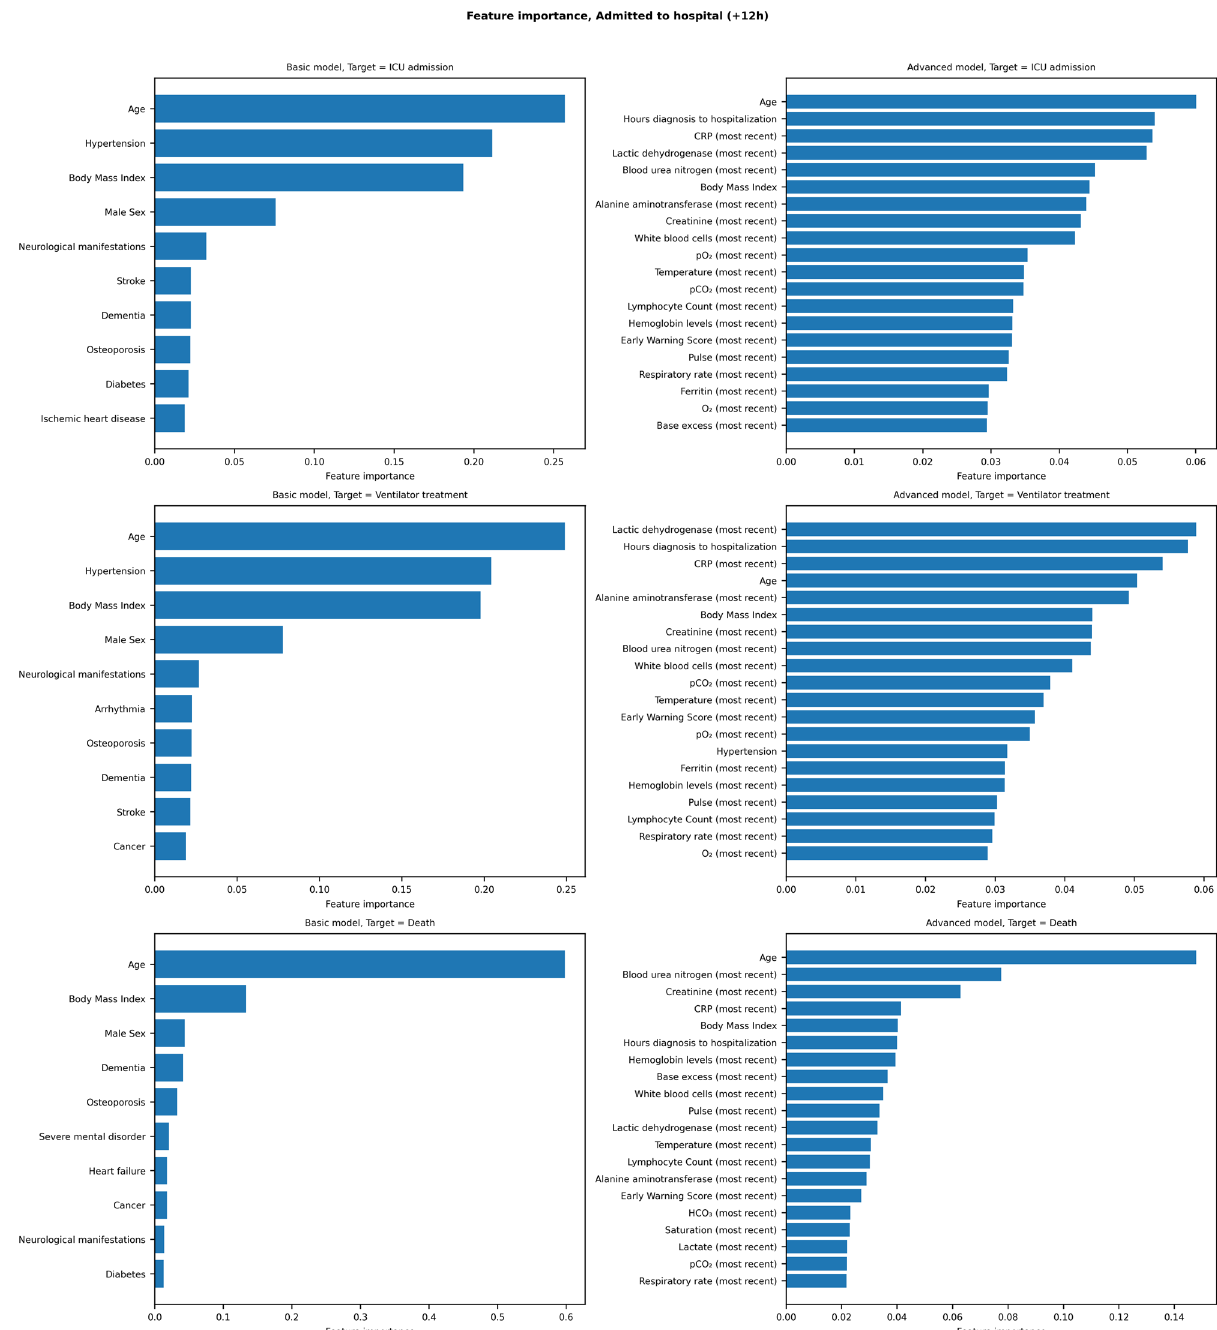
Figure 3. Feature importance for the basic (including age, sex, body mass index, and comorbidities) and advanced (all data) admission models, predicting risk of intensive care admission (first row), ventilator treatment (second row) and death (third row) on hospital